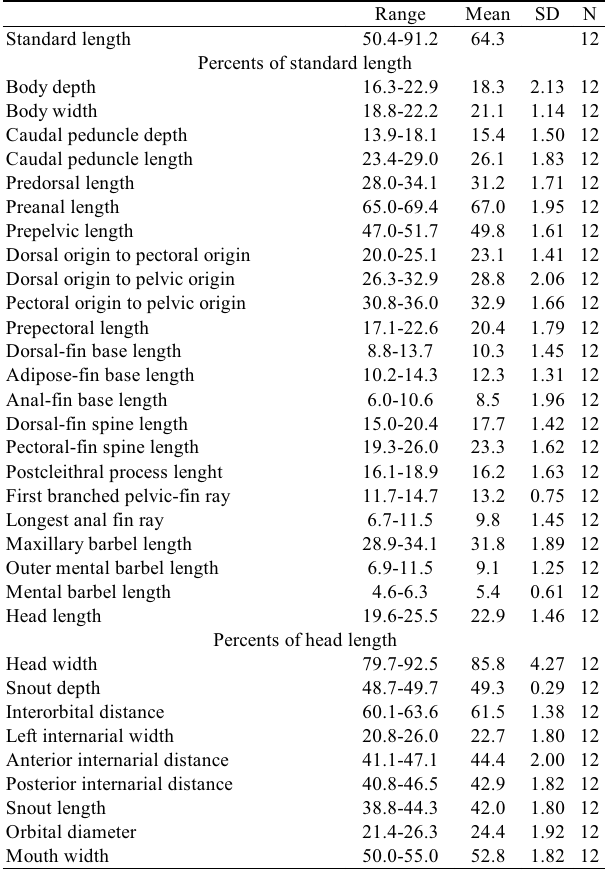
Table 9. Morphometric data for Tatia intermedia . SD = stan- dard